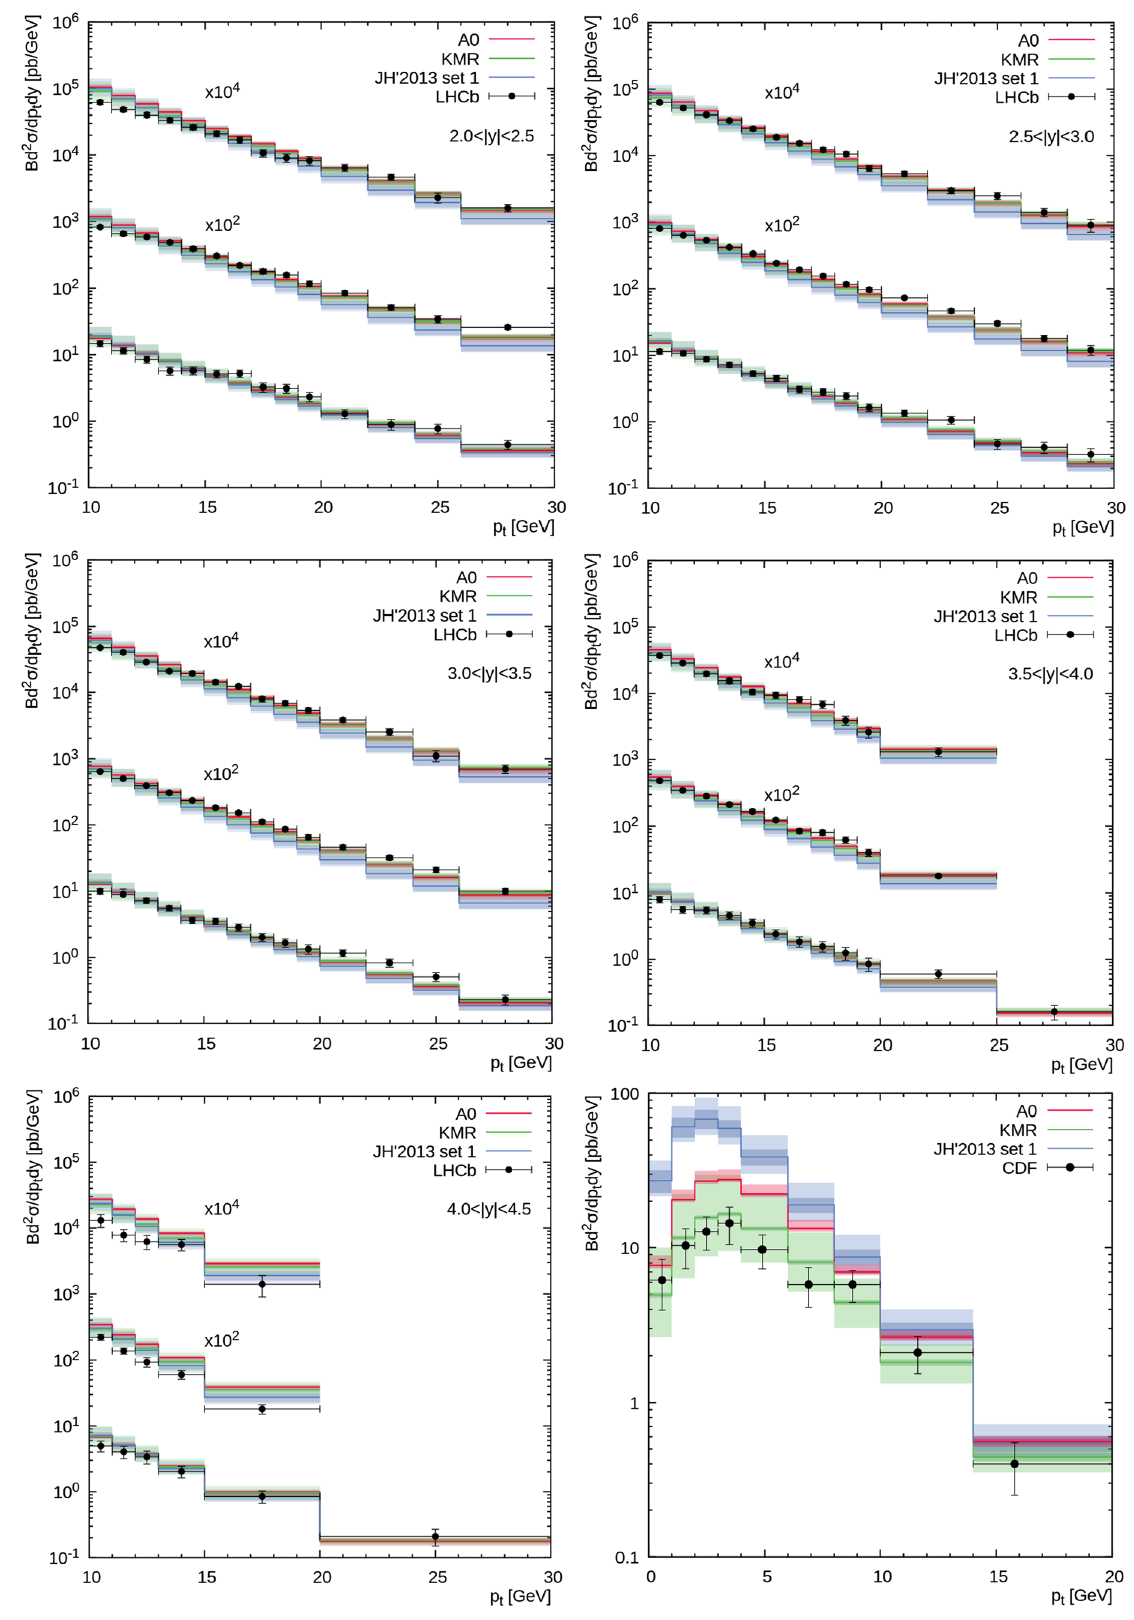
√ s = 1 . 8, 7, 8 and 13 TeV in the different rapidity regions.